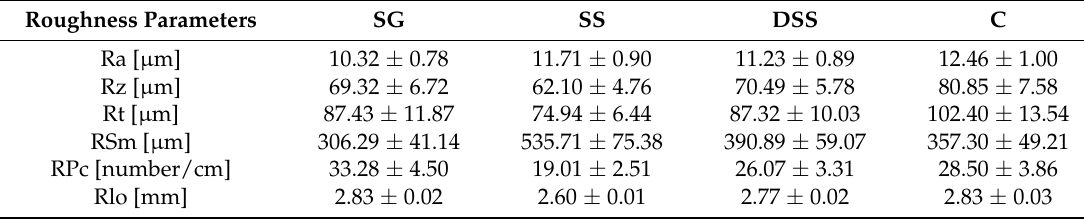
Table 6. The average and standard deviation for roughness parameters.